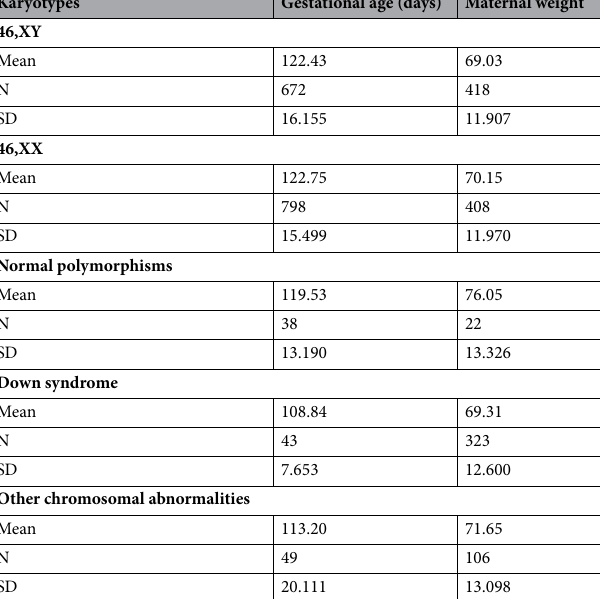
Table 6. Association between the frequency of chromosomal abnormalities and maternal weight as well as gestational age.